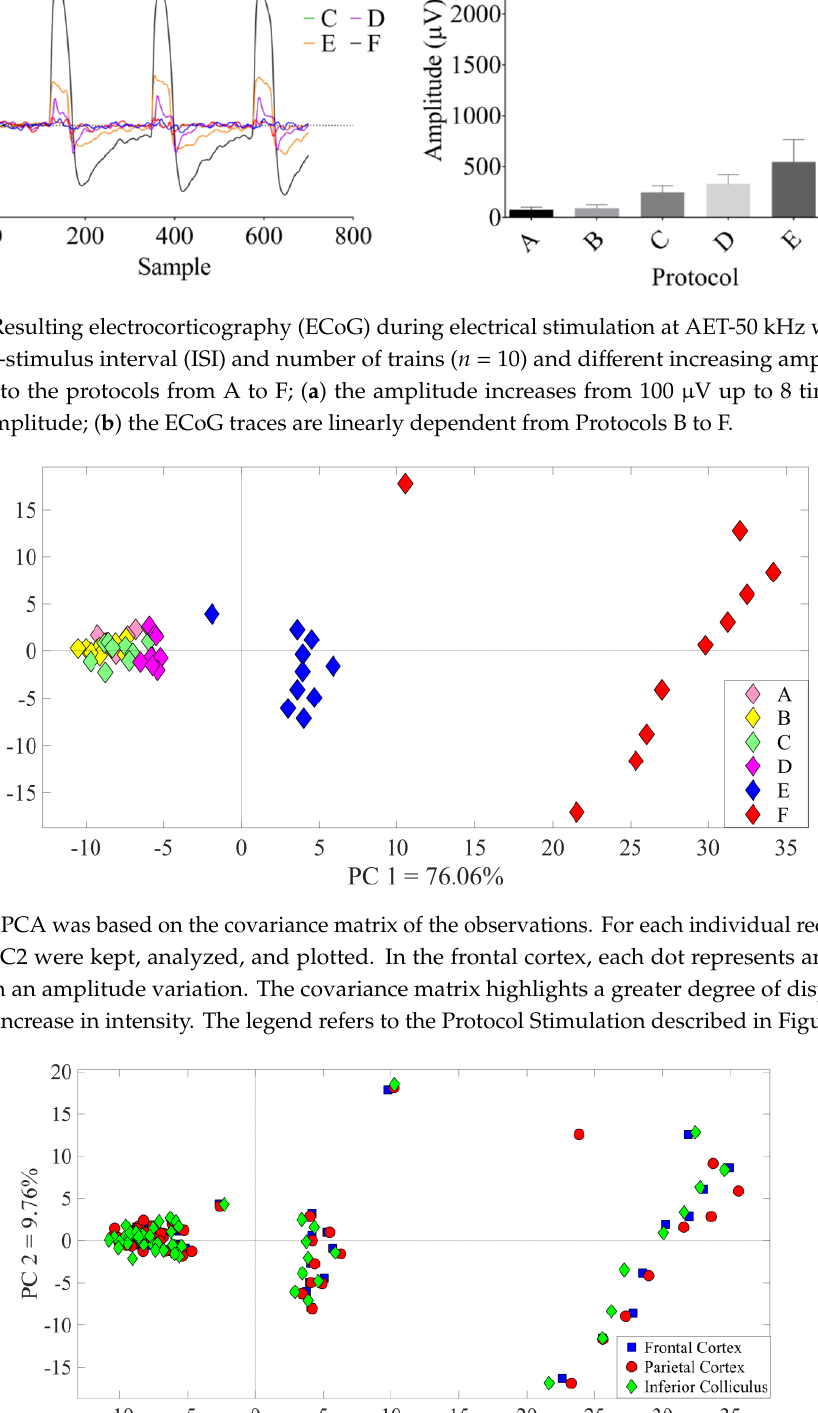
Figure 9. Resulting electrocorticography (ECoG) during electrical stimulation at AET-50 kHz with the same inter-stimulus interval (ISI) and number of trains ( n = 10) and different increasing amplitudes according to the protocols from A to F; ( a ) the amplitude increases from 100 µV up to 8 times the baseline amplitude; ( b ) the ECoG traces are linearly dependent from Protocols B to F.